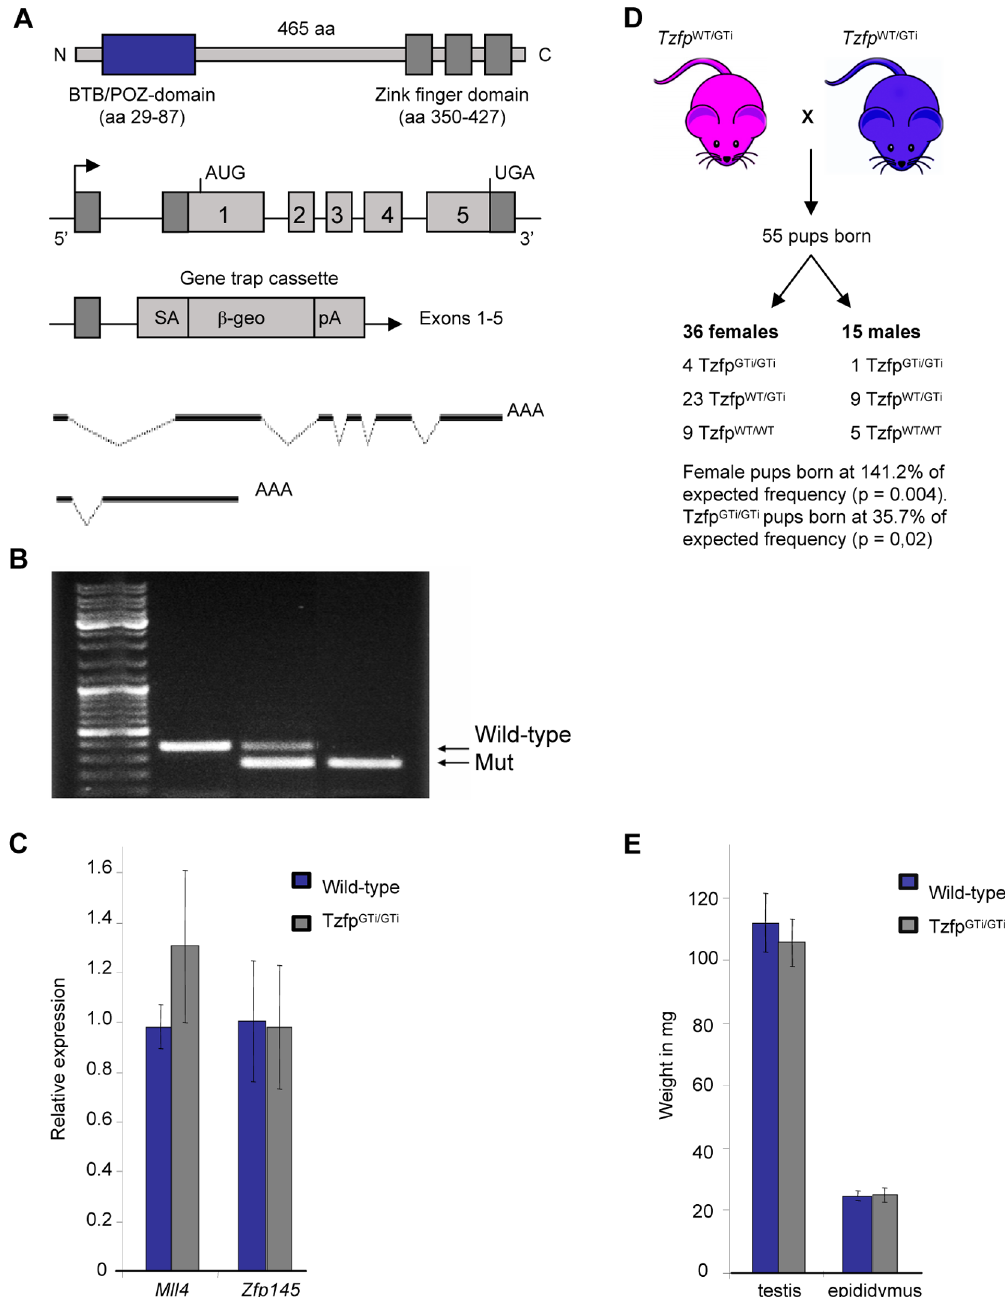
Figure 1. The Tzfp GTi/GTi mouse model. (A) Overview of the Tzfp protein with the BTB/POZ and zink finger domains (top), and of the wild-type and mutated Tzfp allele upon insertional mutagenesis (middle). The wild-type and mutated Tzfp transcript is also included (bottom). (B) Genotyping gel showing fragments indicating samples from wild-type, heterozygous and Tzfp GTi/GTi mice. (C) Gene expression analysis of Mll4 and Plzf in wild-type and Tzfp GTi/GTi testis reveals no significant difference between wild-type and Tzfp GTi/GTi testis. (D) Crosses between heterozygous animals reveal a sex- ratio distortion and fewer than expected homozygous mutant pups. The x 2 -test was used to determine significance. (E) Weight distribution of testis and epididymus in wild-type and Tzfp GTi/GTi mouse reveal a small, but not significant reduction in testis weight in the Tzfp GTi/GTi